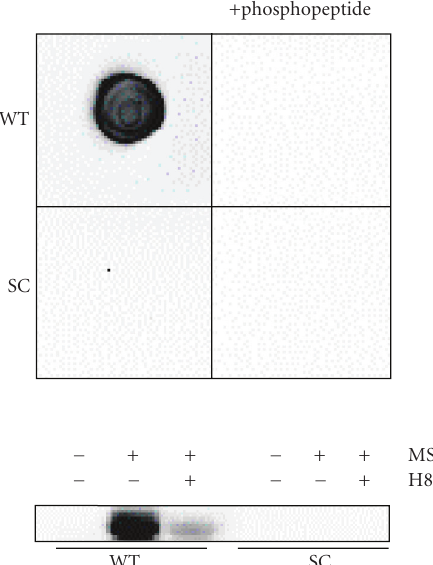
Figure 6: In vitro recognition of the phosphorylated Serine 276 residue of p65 by Cell Signaling no. 3037. Recombinant wt p65-GST or SC mutant p65-GST fusion proteins were in vitro phosphorylated using recombinant MSK-1. 250ng of the recombinant proteins were spotted on a nitrocellulose membrane and subjected to Western Blotting with Ser276 phospho-specific p65 antibody, either preincubated with 10 μ g/mL phosphorylated peptide that was used to generate the antibody (upper panel) or not. 1 μ g of recombinant protein was separated by SDS-PAGE after the in vitro kinase assays performed either in the presence of active MSK-1 and/or 10 μ M H89 (lower panel) or